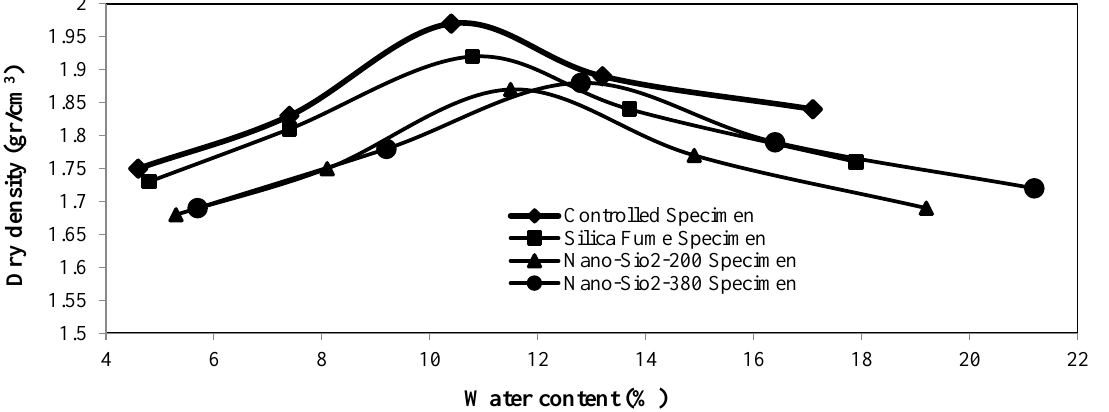
Fig. 6. The effects of type of silica material on the compaction properties